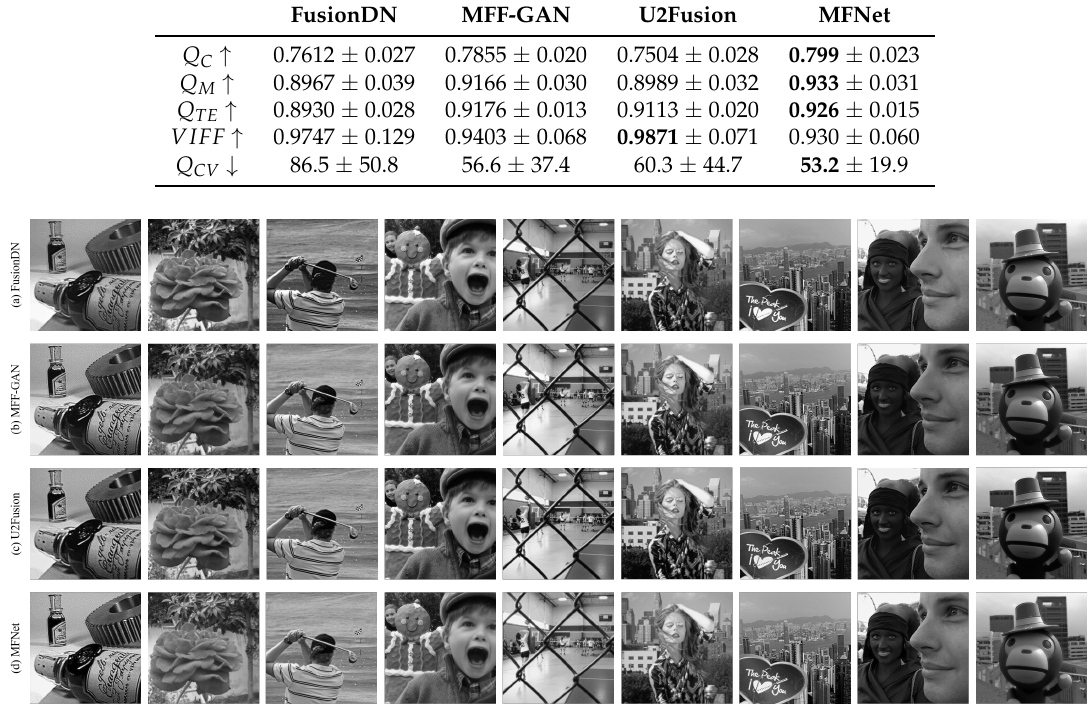
Figure 11. Fused results of nine pairs of source images obtained by different deep unsupervised learning fusion